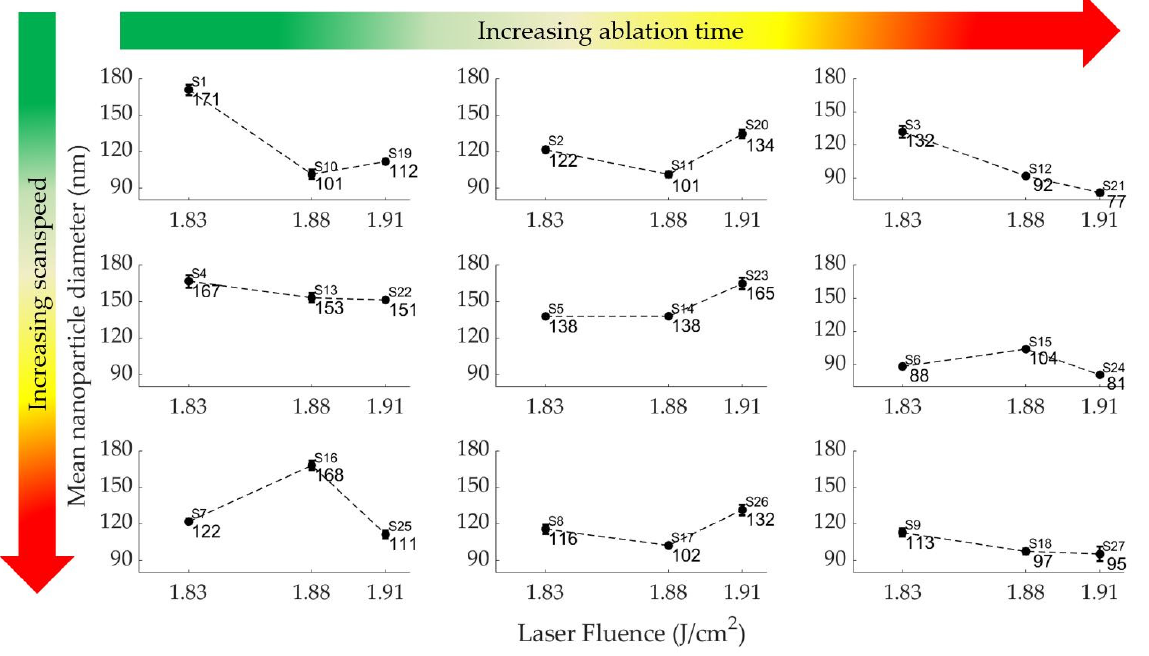
Figure 6. Effect of laser fluence on nanoparticle mean diameter (nm).